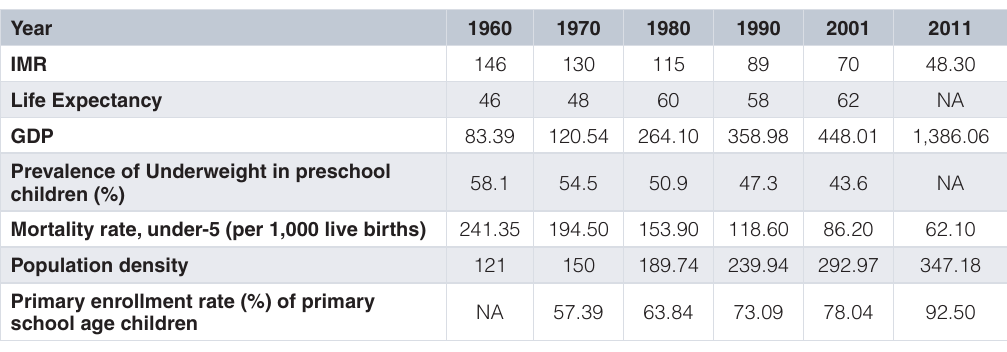
Table 1. Trend in selected economic and development indicators in South